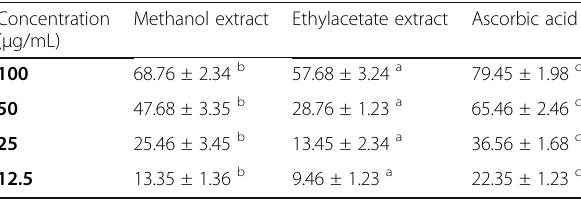
Table 4 Hydroxyl radical scavenging activity of methanol and ethyl acetate extract of Azanza garckeana whole pulp Concentration ( μ g/mL)